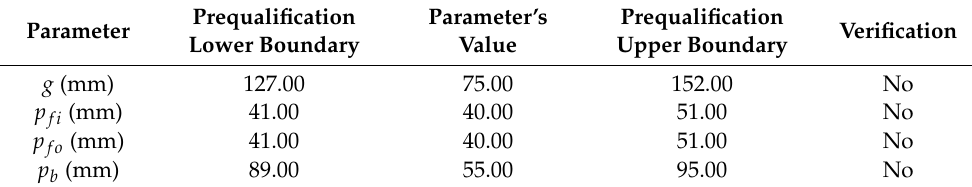
Table 3. Bolt location characteristics vs. prequalification